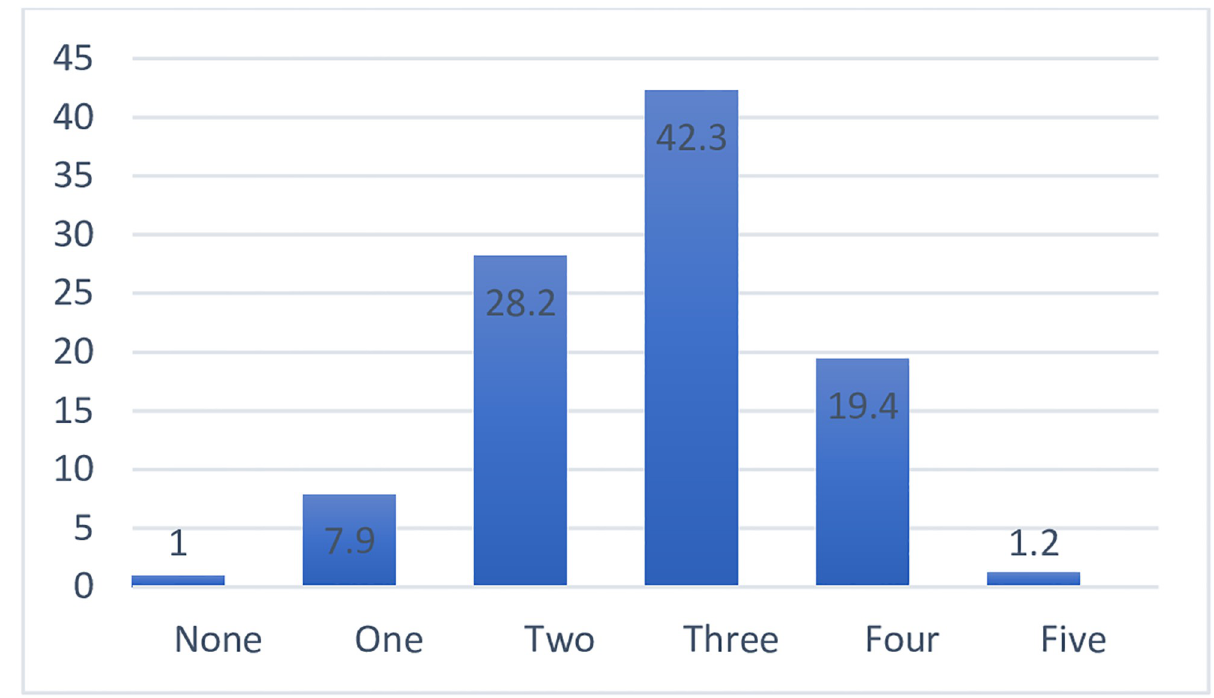
Fig 3. Distribution of the number of cardiovascular disease risk factors in the study population.